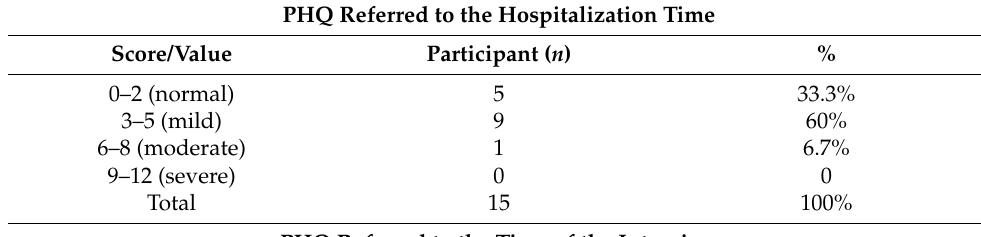
Table 4. Participants’ emotional and mental feelings from PHQ.